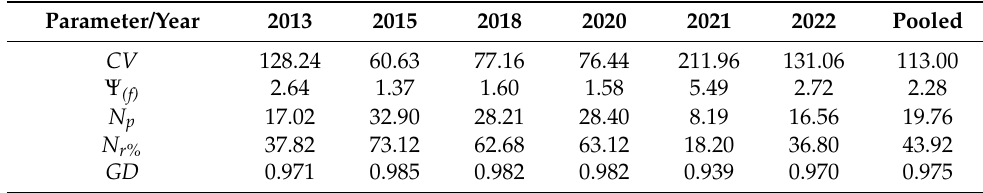
Table 5. Clonal coefficient of variation ( CV ), female fertility coefficient ( Ψ f ), effective number of female parents ( N p(f) ), relative effective number of female parents ( N r% ), and gene diversity ( GD ) in the Silver fir clonal seed orchard.